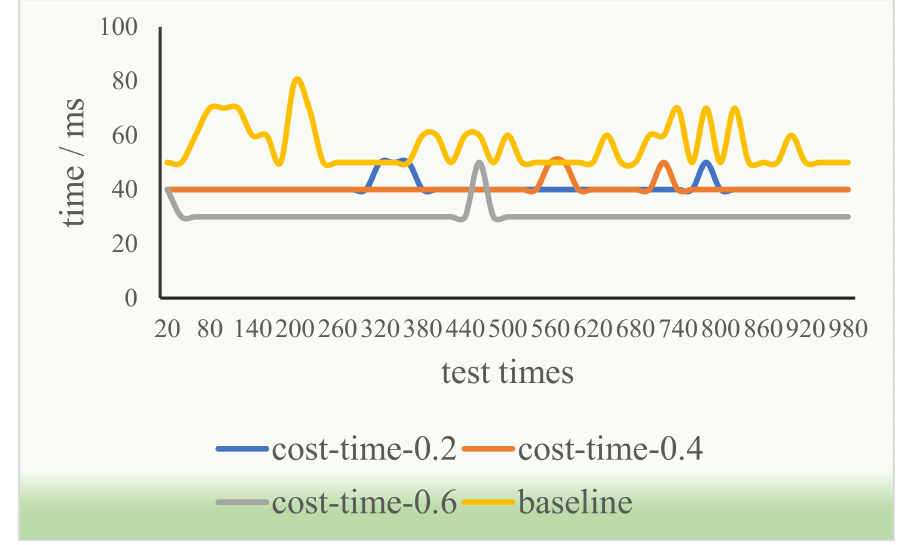
Figure 9. Time consumed in